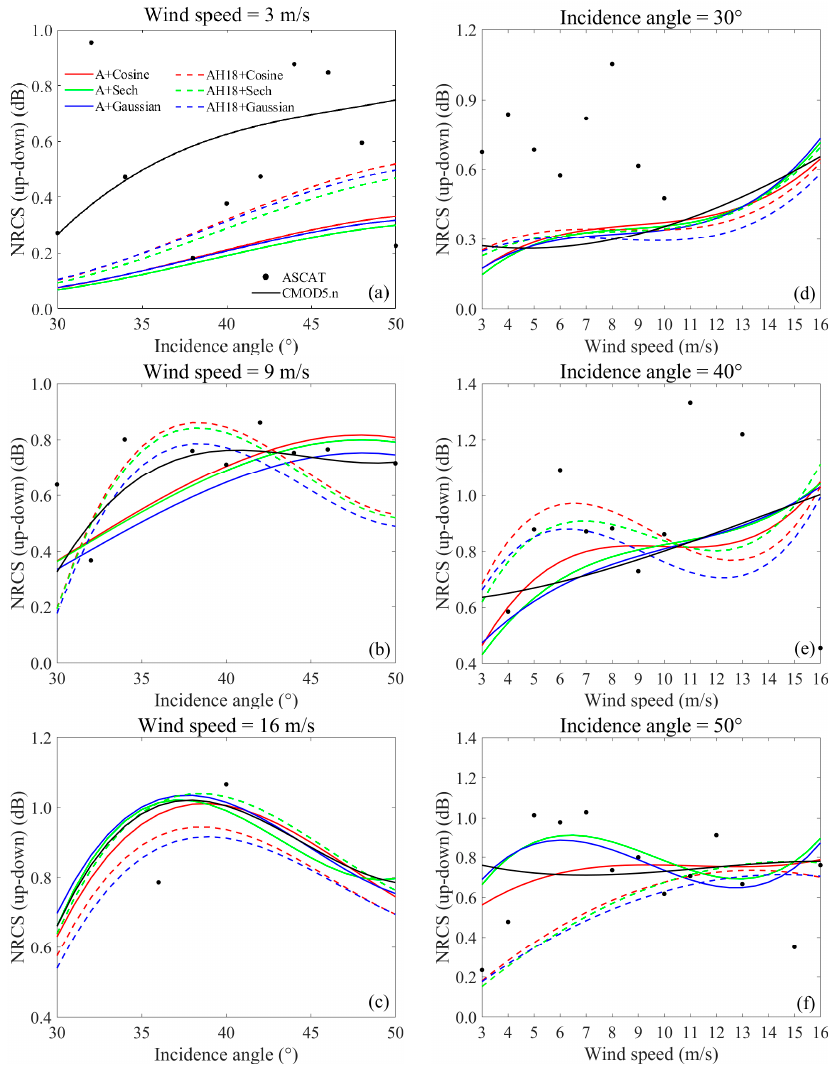
Figure 10. Upwind–downwind asymmetry predicted by the modified TSM with different wave directional spectra input, and their comparison with the ASCAT and CMOD5.n. ( a – c ) As a function of incidence angle at wind speeds of 3 m/s, 9 m/s, and 16 m/s. ( d – f ) As a function of wind speed at incidence angles of 30°, 40°, and 50°.